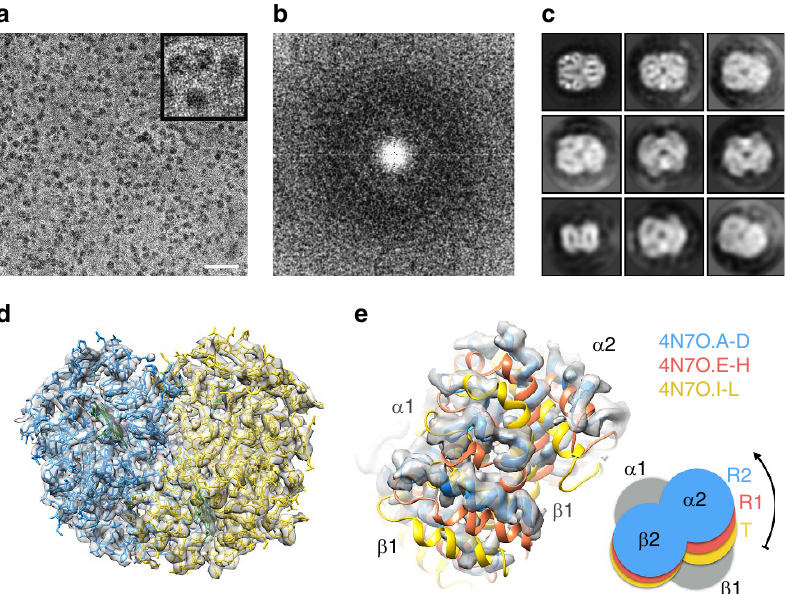
Figure 1 | Phase plate imaging of 64kDa Hgb. ( a ) Electron micrograph of metHgb recorded at B 500nm underfocus with the Volta phase plate (VPP) (scale bar, 30nm). ( b ) Power spectrum of the image in a , featuring contrast transfer function (CTF) Thon rings permitting defocus and phase shift estimation. ( c ) The 2D class averages of Hgb showing secondary structure elements in projection. ( d ) Reconstructed 3D electron scattering potential map and model of Hgb. ( e ) VPP reconstruction fitted with three conformers of Hgb present in crystal structure PDB 4N7O. The reconstructed 3D map agrees best with chains A–D of PDB 4N7O representing the R2 state of